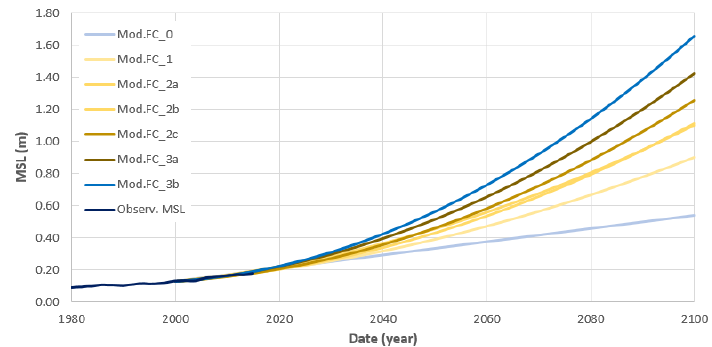
Figure 7. Relative SLR projection models for the WCPM (in meters), superimposed with observed MSL at Cascais TG.